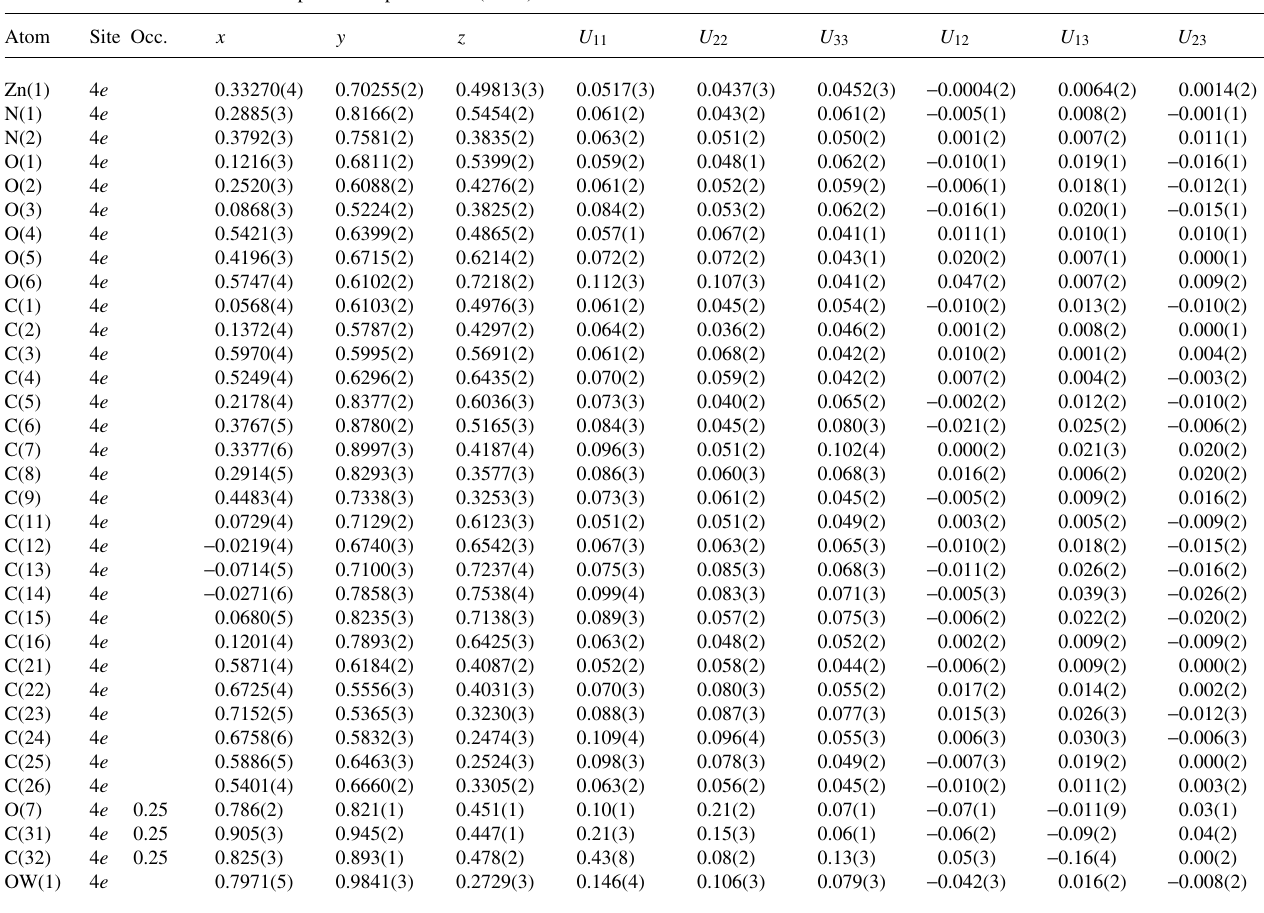
Table 3. Atomic coordinates and displacement parameters (in Å 2 ) .